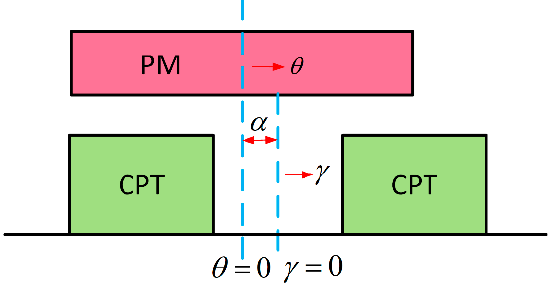
Figure 7. Relative position of PM and CPT.